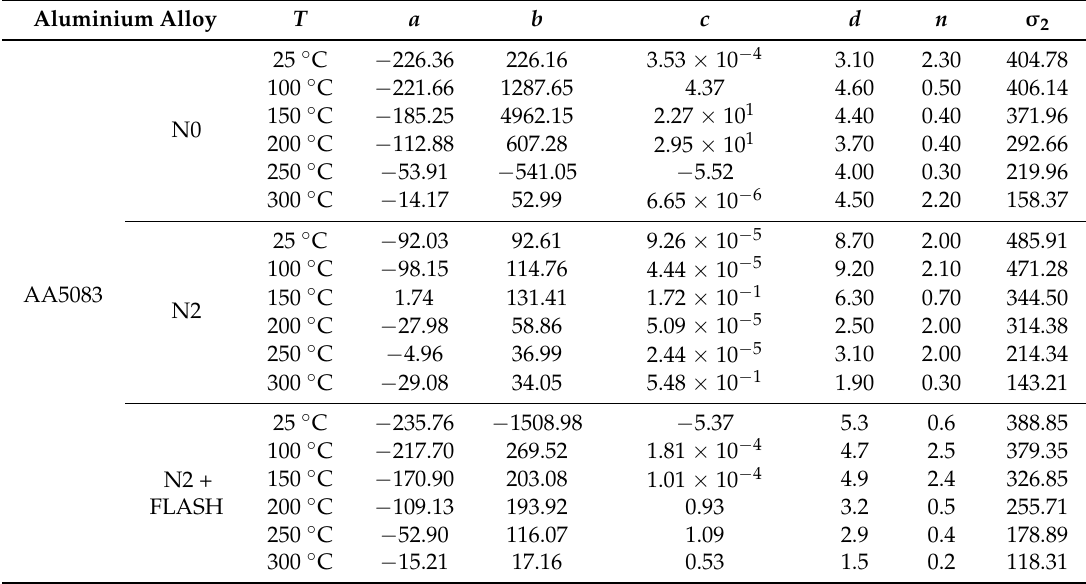
Table 4. Values of the parameters for the new flow rule proposed for AA5083.